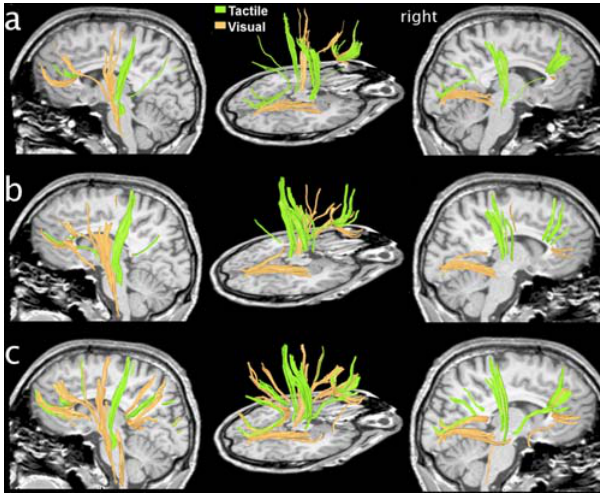
Figure 6. Positively correlated fDTI results for subject # 5 computed in three different ways. (a) The original active tracts found based on changes in FA using the sign-test (See Figure 1). (b) Analysis of the same data set using conventional t-statistics as in ROI/ VOI based fMRI. For each voxel in the fDTI scan a multiple regression was carried out. Two regressors were used, one encoding for the stimulus (0/1) and the other representing possible linear scanner drift. Each tract that was tested for activation was considered active if the mean of the stimulus regressor values of the voxels in the tract was found significantly higher than zero using a one-sided Student’s t-test (p , 0.05; Bonferroni corrected for the number of tested tracts). (c) Active tracts based on changes in the radial diffusion component using the sign-test. The three different methods yielded very similar activation patterns. The similar results for (a) and (b) indicate that the results do not depend on the chosen statistical method. The similar results for (a) and (c) indicate that the measured signal change stems predominantly from a change in diffusion in the radial direction.